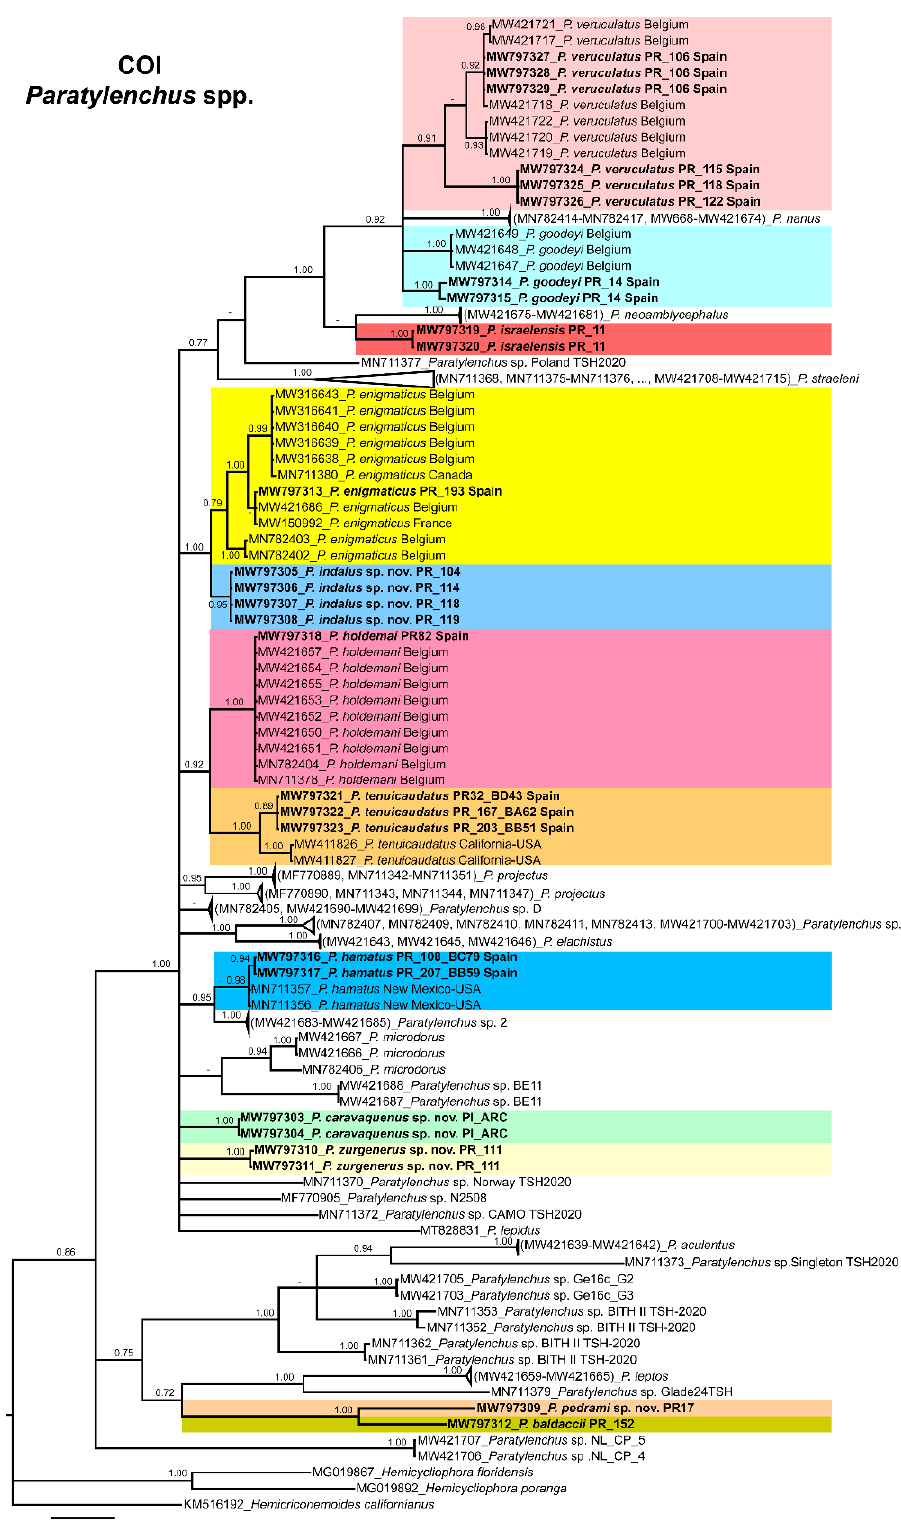
Figure 22. Phylogenetic relationships within the genus Paratylenchus . Bayesian 50% majority rule consensus tree as inferred from COI sequence alignment under the general time-reversible model of sequence evolution with a gamma-shaped distribution (GTR + G). Posterior probabilities of more than 0.70 are given for appropriate clades. Newly obtained sequences in this study are shown in bold. The scale bar indicates expected changes per site.